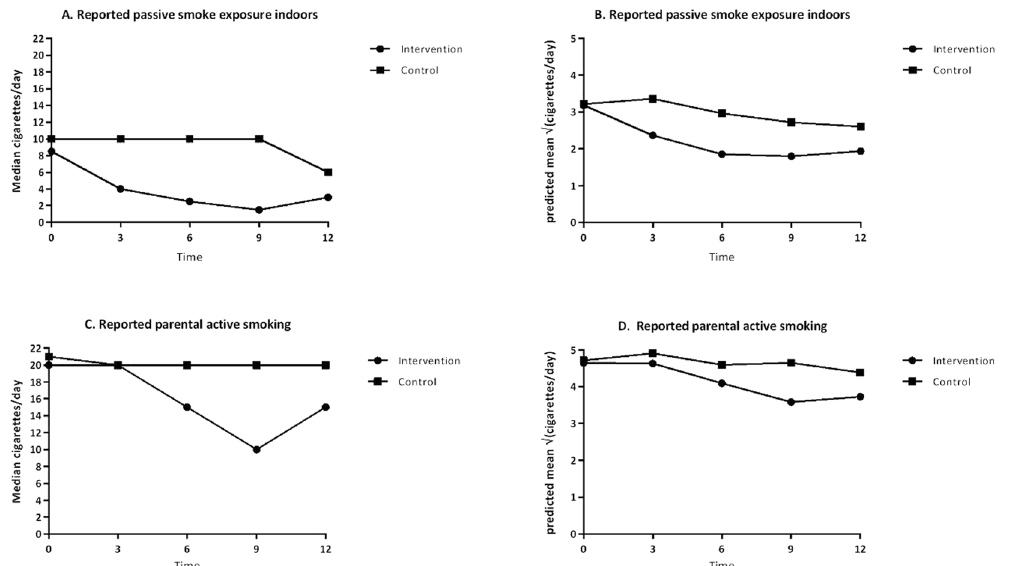
Figure 2. Amount of cigarettes smoked in the presence of the child indoors and amount of cigarettes smoked by parents (actively). ( A ) Median amount of cigarettes smoked in the presence of the child indoors. ( B ) Predicted mean square root of the amount of the cigarettes smoked in the presence of the child indoors, based upon the Generalized Linear Mixed-effects Models (GLMM) model analysis of all available data after square root transform and without imputing missing values. ( C ) Median amount of cigarettes smoked by parents (active smoking). ( D ) Predicted mean square root of the amount of the cigarettes smoked by parents based upon the GLMM analysis of all available data after square root transform and without imputing missing